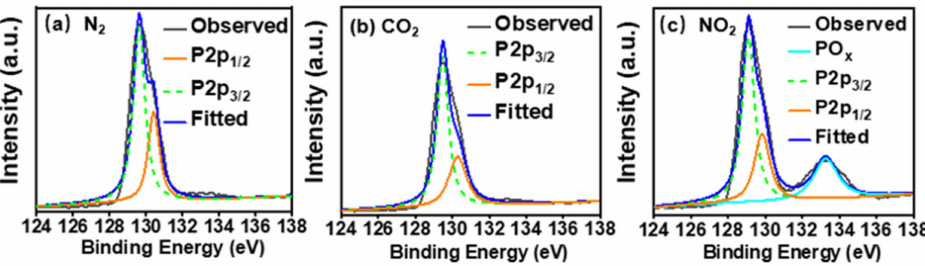
Figure 6. XPS spectra (P 2p) of LBP nanoflakes exposed to N 2 ( a ), CO 2 ( b ), or NO 2 ( c ) for